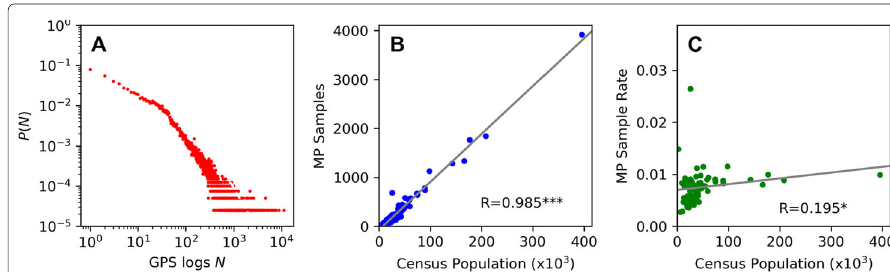
Fig. 1 Statistics of mobile phone data. a Probability density plots for the number of GPS logs per day for a user in Puerto Rico. The distribution is a power law, with mean 83 and standard deviation 262. b Mobile phone samples in each county is highly correlated with county-based census population in Puerto Rico. c Census population of each county has no effect on the mobile phone sampling rates, showing no spatial bias in the sampling distribution of the data